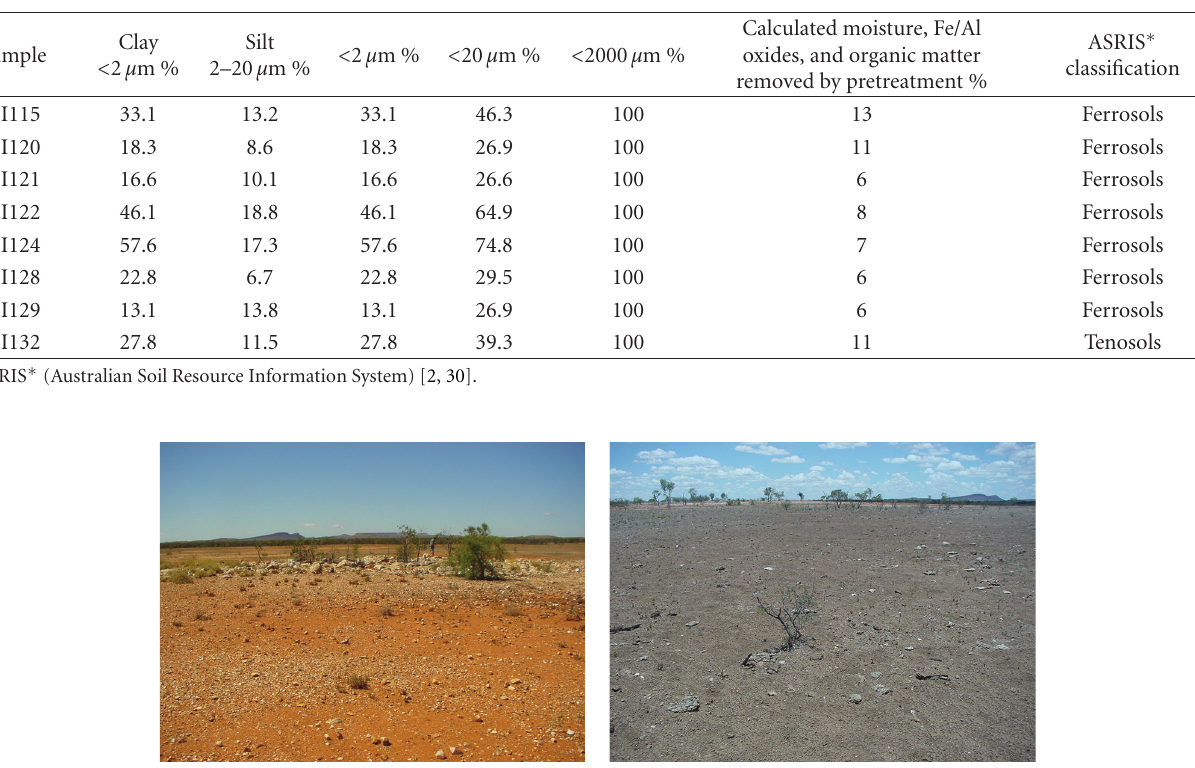
Table 2: Tick Hill soil sample particle analysis results using Method code 517.08 of [29] where Fe/Al oxides, organic matter, and soluble salts are removed.